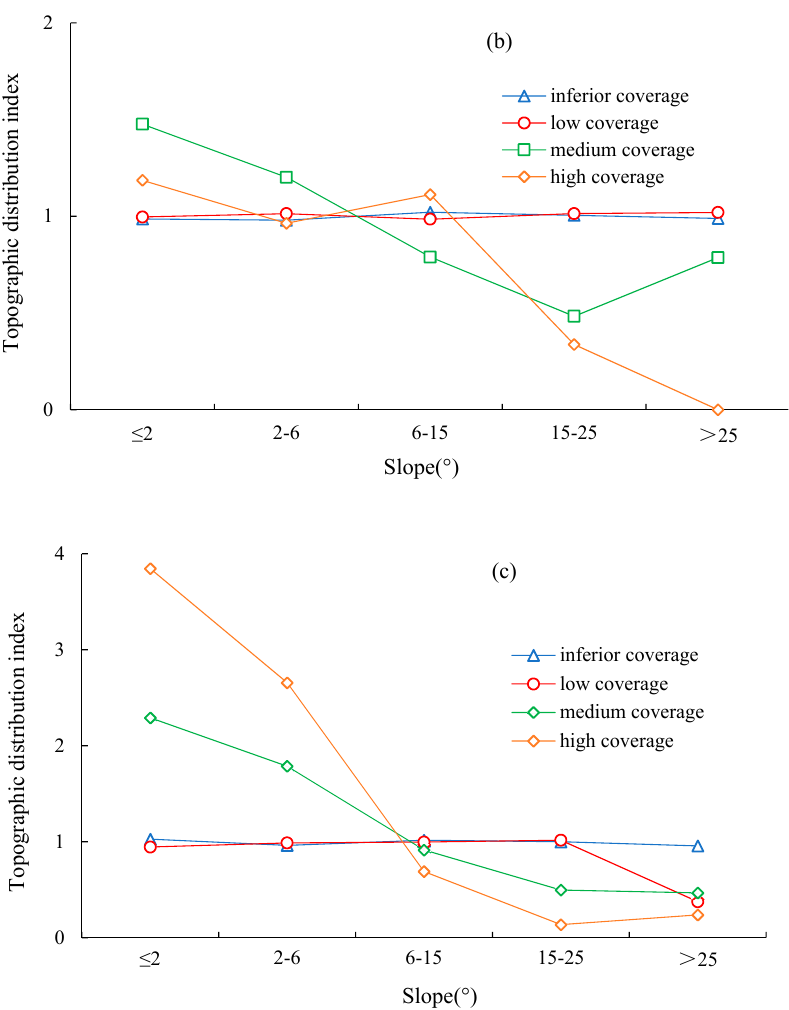
Figure 12. Variations in topographic distribution index and slope in different fractional vegetation coverage levels. ( a ) Bare Pisha sandstone; ( b ) Sand-covered Pisha sandstone; ( c ) Soil-covered Pisha sandstone.